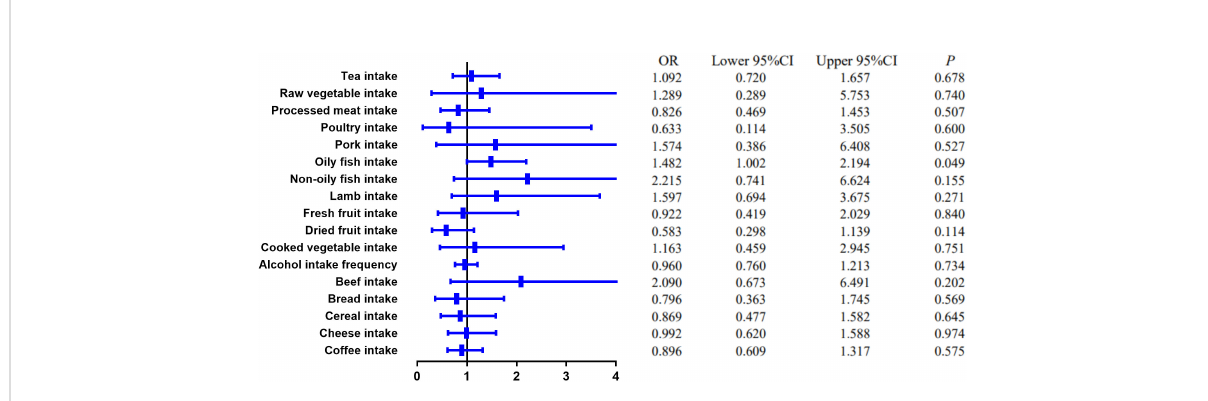
FIGURE 3 The causal effect of food risk factors on UC based on the IVW method. Abbreviations: IVW, inverse-variance weighted; UC, ulcerative